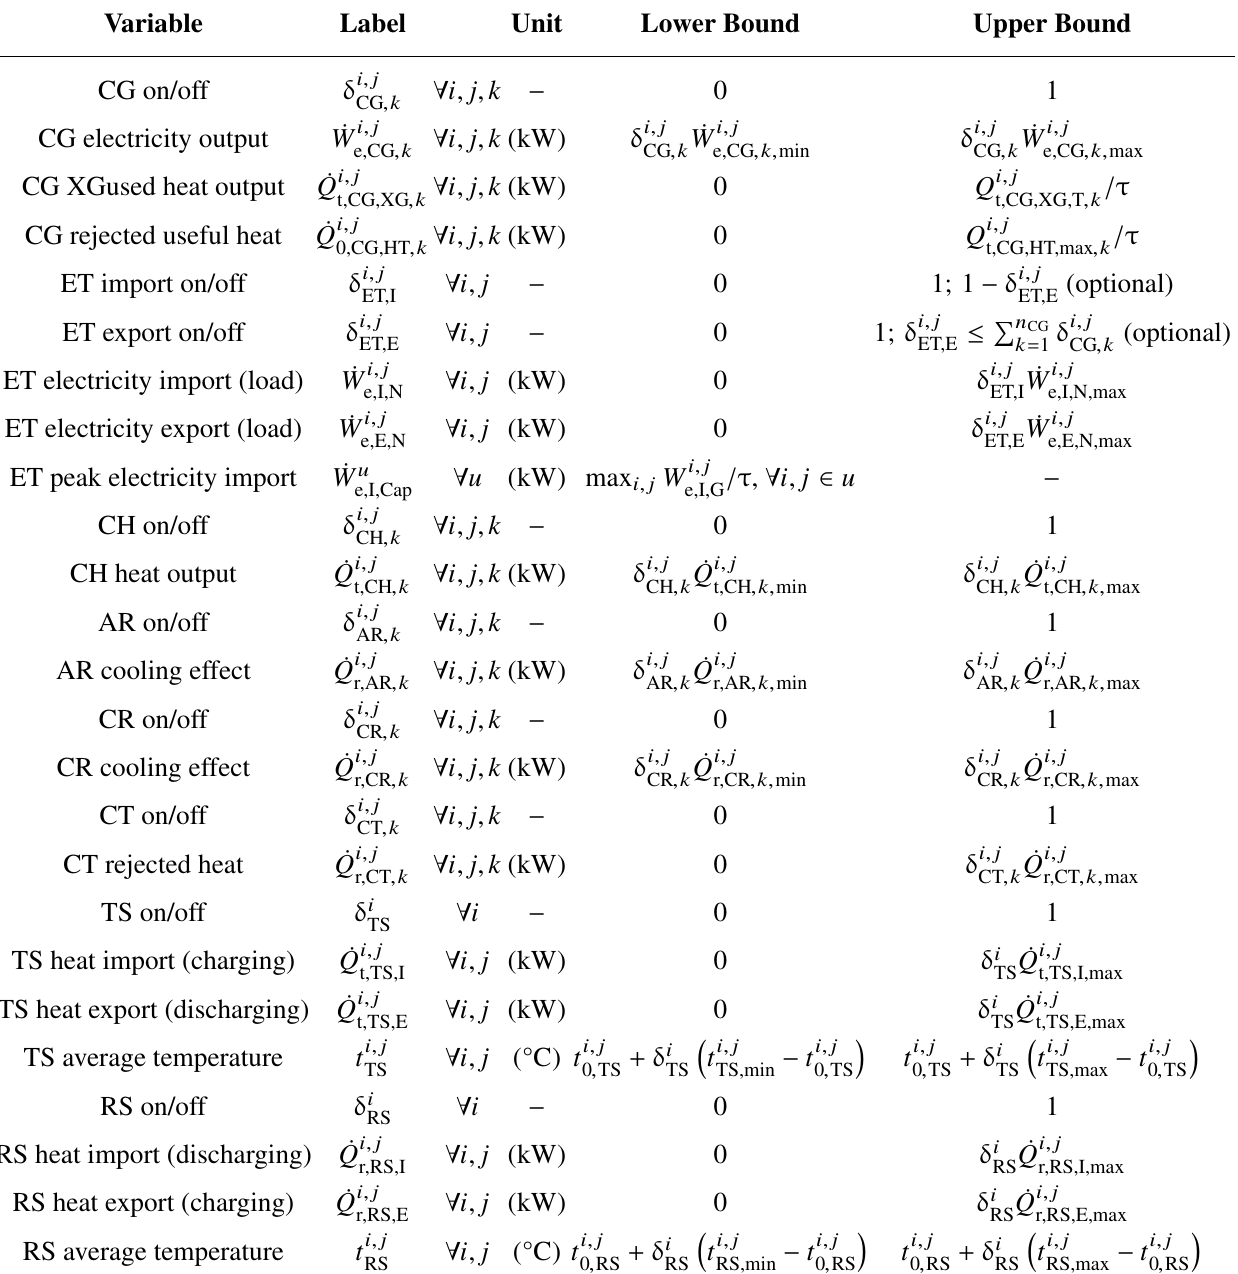
Table 1. Summary of the main operation optimization decision variables. CG, cogeneration unit; ET, electrical transformer; CH, hot water boiler; AR, absorption chiller; CR, compression chiller; CT, cooling tower; TS, heating storage tank; RS, cooling storage